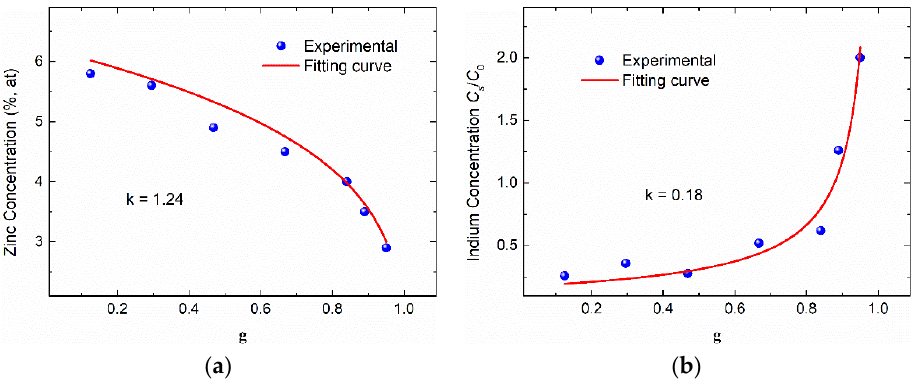
Figure 3. Elemental concentration along the growth direction measured using GDMS. ( a ) Zn distribution and( b )normalizedIndistribution. g isthenormalizedaxialpositionintheingot, where g = 0corresponds to the tip of the ingot, and g = 1 is the tail of the ingot. The solid blue circles show experimental results and the red solid lines are fitting curves modeled using Equation